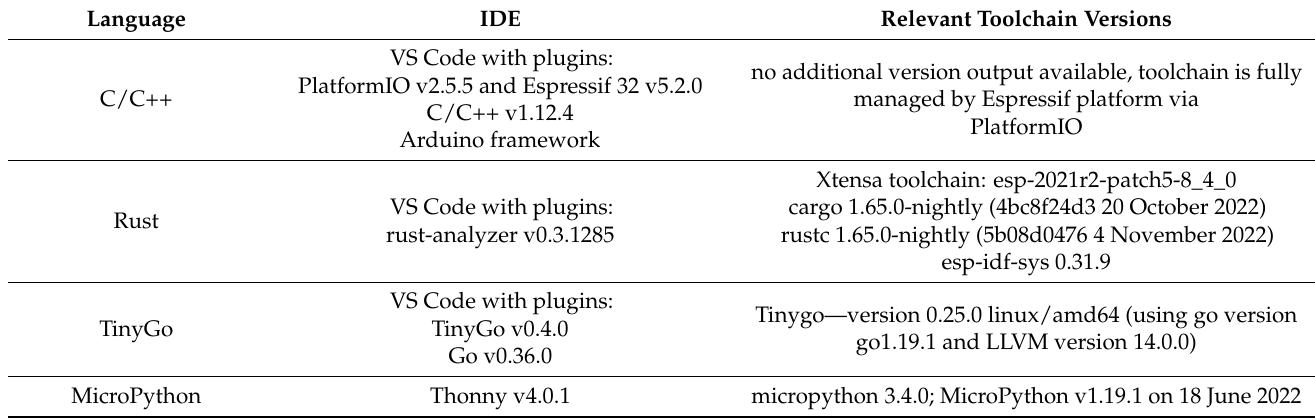
Table 4. Overview of the development environment used for each programming language.